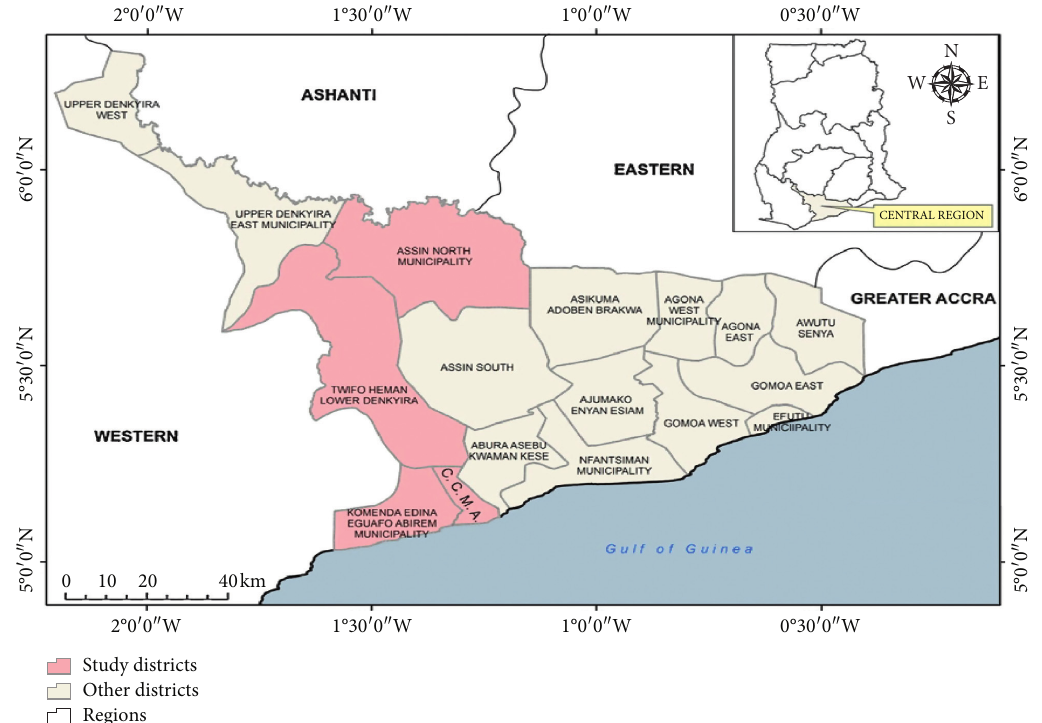
Figure 1: Map of Central Region of